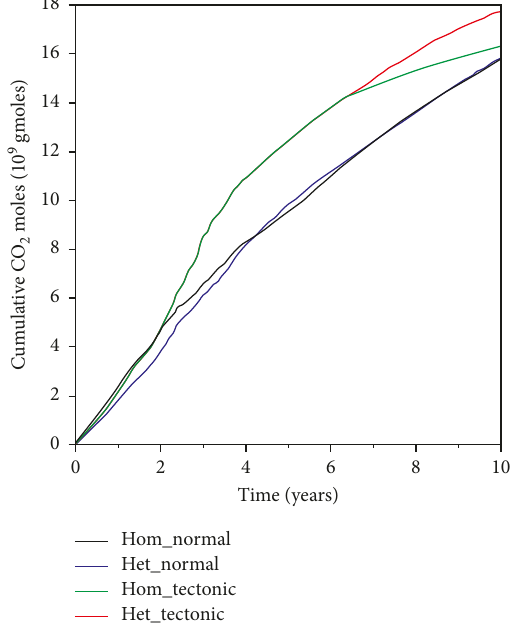
Figure 11: Cumulative in-place amounts of CO different times under the additional tectonic stress ( V DP